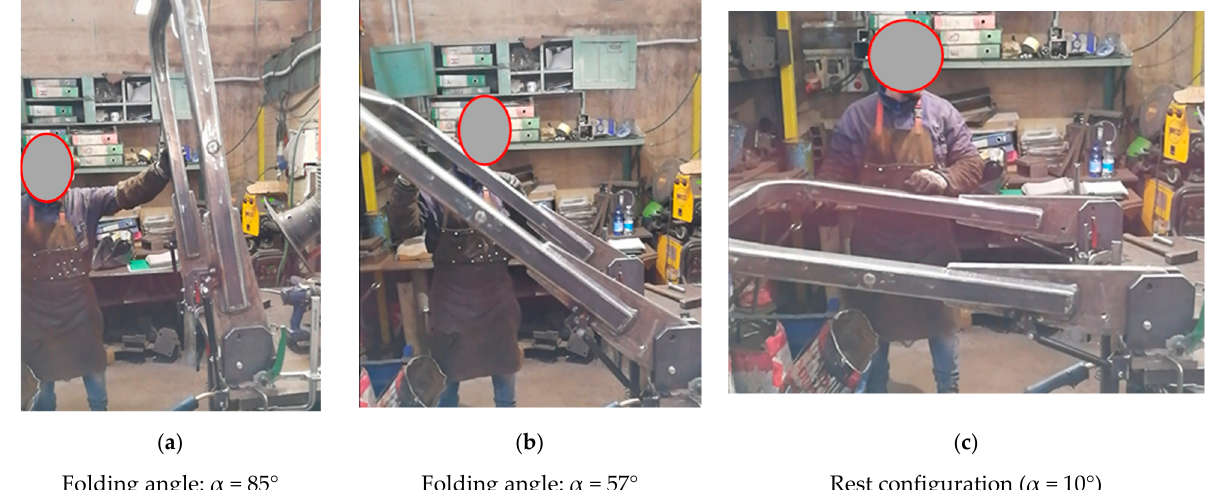
Figure 14. Practical tests concerning the lowering operations.